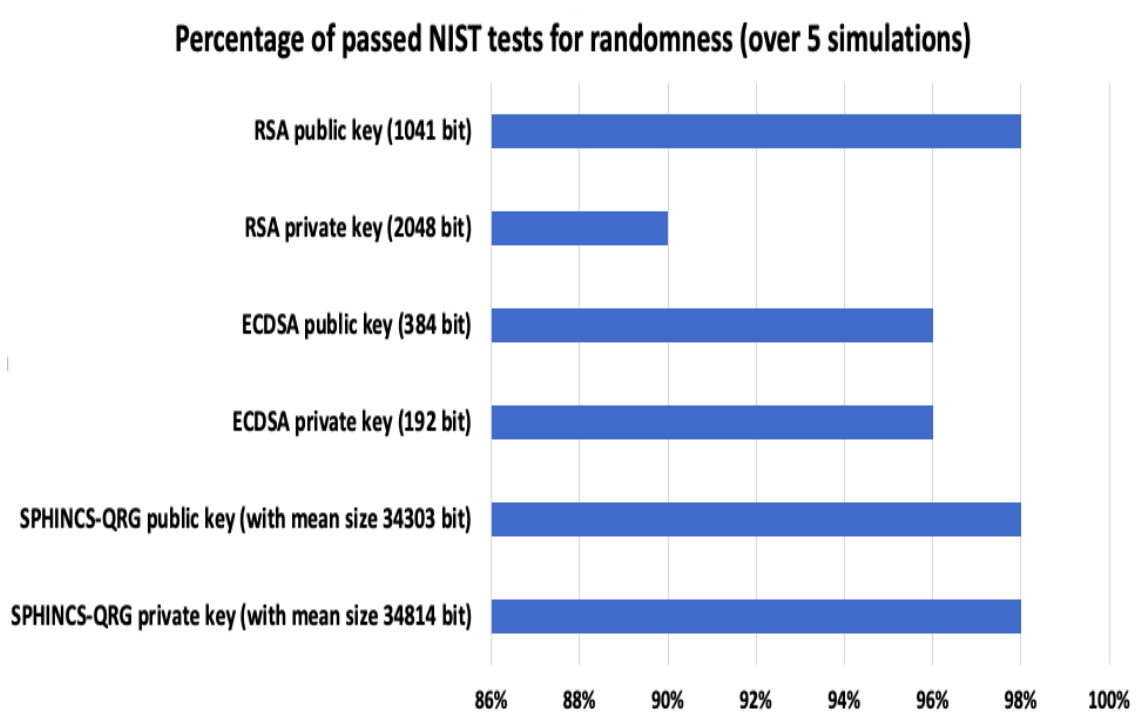
Figure 15. Percentage of passed tests, by RSA, ECDSA and SPHINCS-QRNG key pairs, based on NIST statistical test suite on